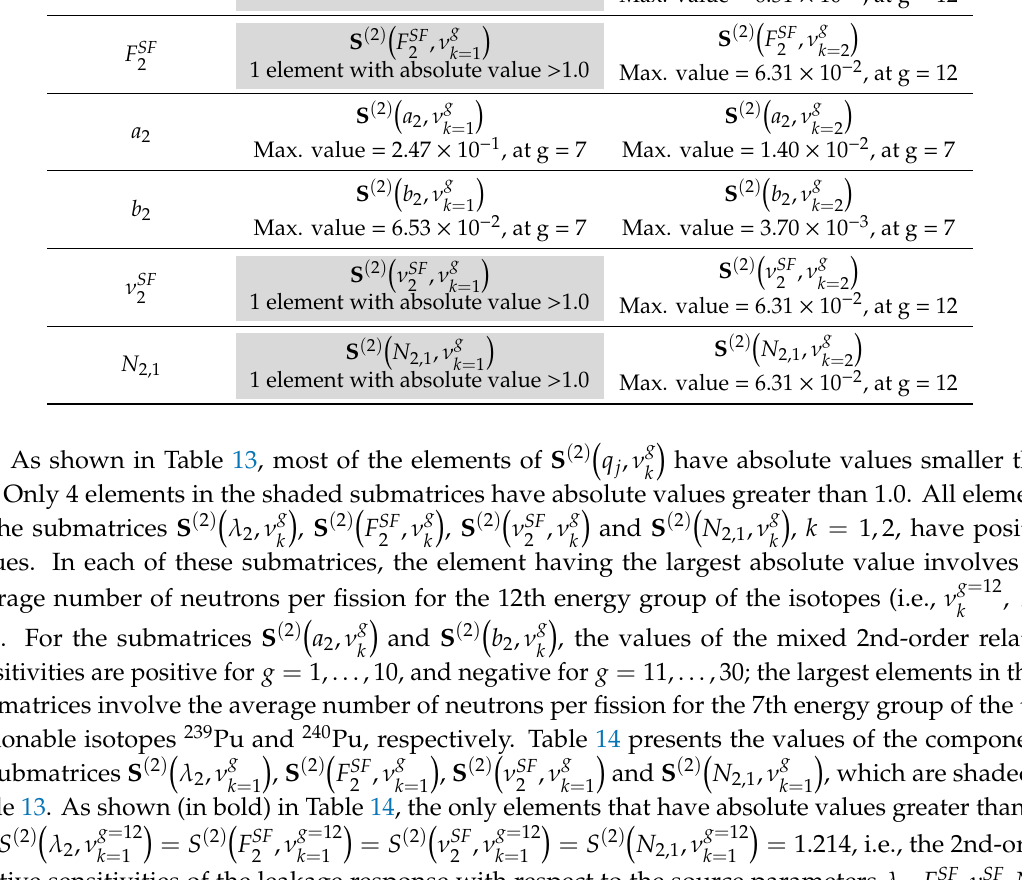
(cid:16) (cid:17) q j , ν g , j = 2,4,6,8,10,12 ; k = 1,2; g = 1, ... ,30, for 2nd-order k